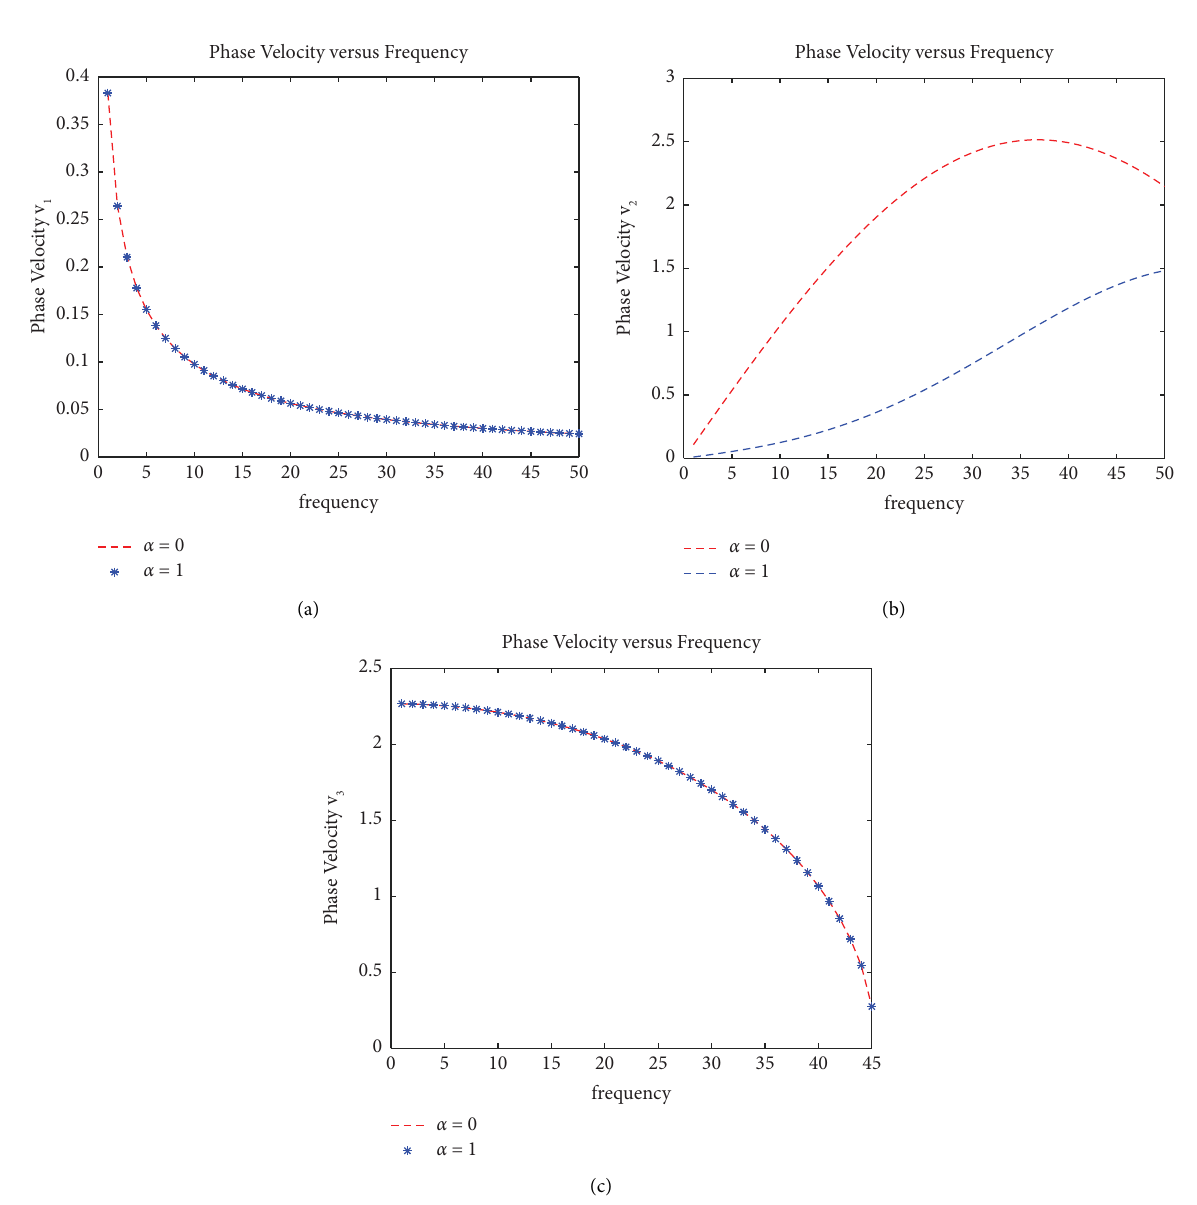
Figure 2: Phase velocity w.r.t. frequency ω